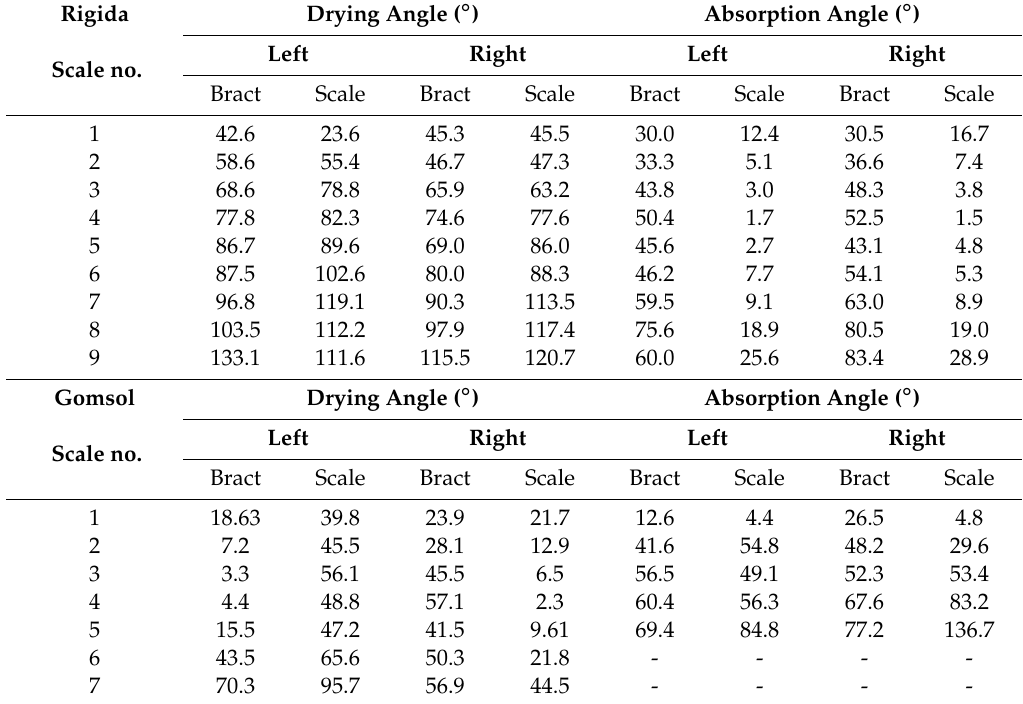
Table 1. Opening and closing angles of cone scales according to drying and water absorption. Rigida Drying Angle ( ◦ ) Absorption Angle ( ◦ ) Left Right Left Right Scale no. Bract Scale Bract Scale Bract Scale Bract Scale 1